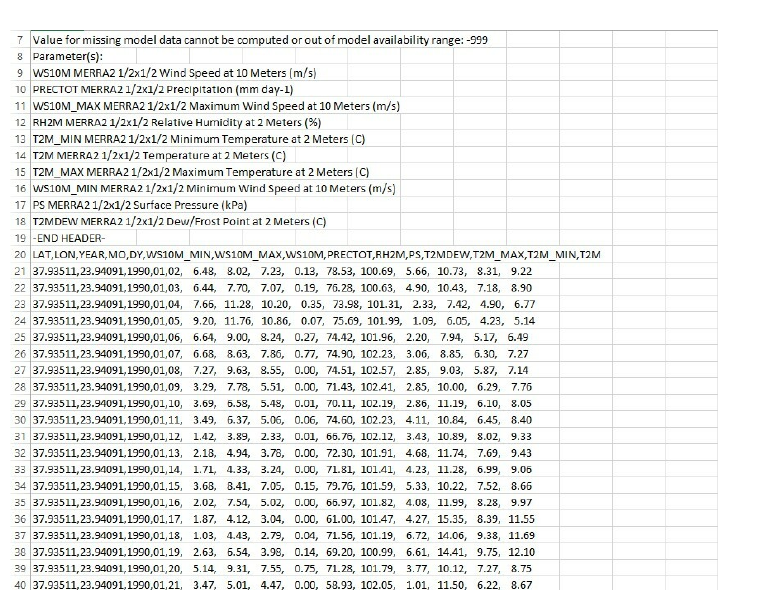
Figure 3. An example of a raw csv file. The cleansing stage includes data splitting and column conversions and data structure reformatting for their transformation to a standardized format ready to be loaded to